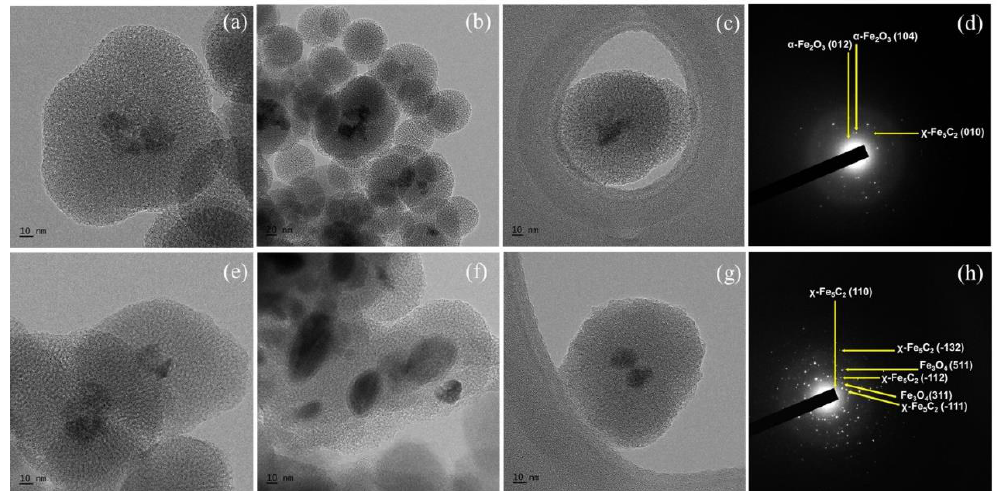
Figure 3. ( a – c ) TEM images and ( d ) SAED pattern of fresh χ -Fe 5 C 2 @SiO 2 _L catalyst; ( e – g ) TEM images and ( h ) SAED pattern of fresh χ -Fe 5 C 2 @SiO 2 _H catalyst. The average crystallite size of χ -Fe 5 C 2 in the χ -Fe 5 C 2 @SiO 2 _H catalyst calculated at 2 θ = 39.4 ◦ from the XRD result was 20.03 nm after the nanoparticles were encapsulated,